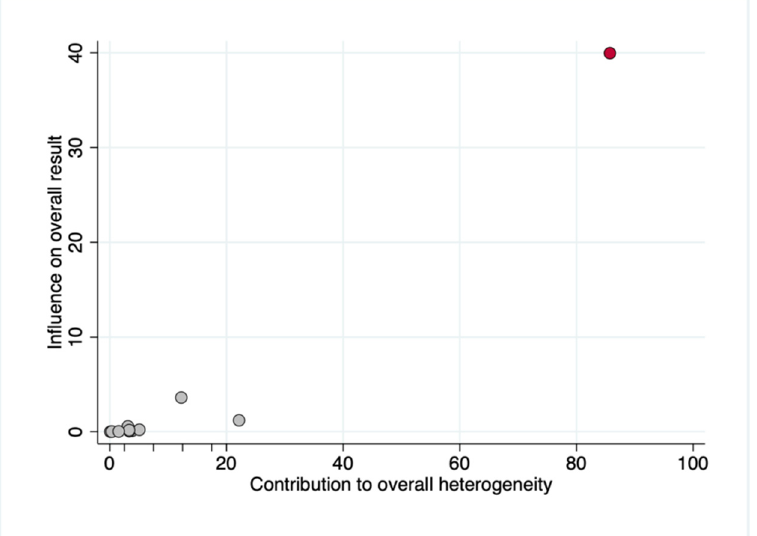
Figure 8. Baujat plot depicting the contribution of individual studies to overall heterogeneity on the x -axis (i.e., relative contribution to the Q-statistic) plotted against influence on the overall result on the y -axis (leave-one-out method). A Baujat plot was applied to identify the specific subsamples sharing potential sources of heterogeneity. The most heterogeneous and influential primary-level studies should appear in the upper right area of the graph. ID labels were included to allow easier identification of the studies. This graphical method allowed us to identify that Tozüm et al. [41] (depicted as a red circle) provided the greatest contribution to heterogeneity, and could potentially harbor differential clinical, methodological or statistical characteristics as the main source of heterogeneity.